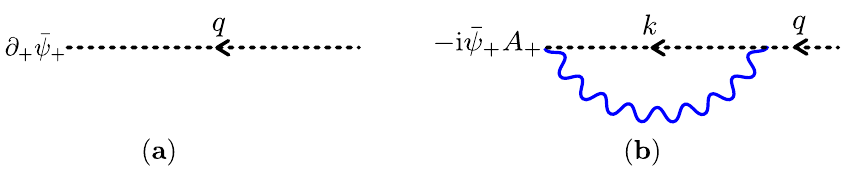
Figure 10 . The two diagrams that contribute to the modified propagator D (1) Wave function normalization